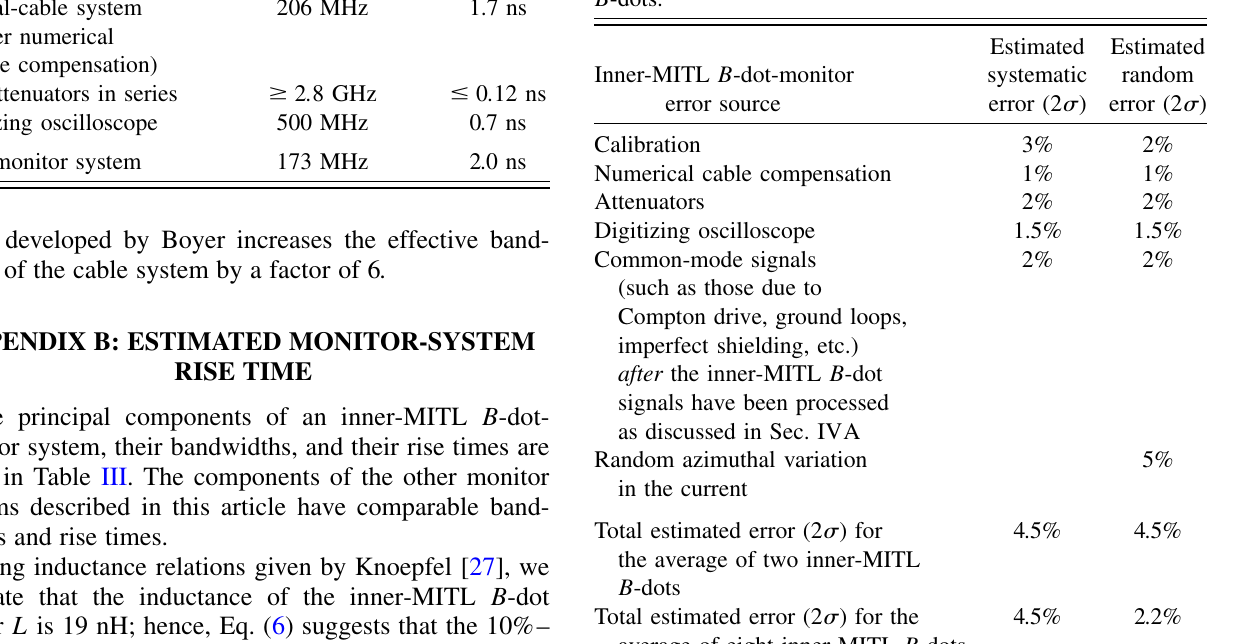
TABLE IV. Estimated systematic and random errors of the inner-MITL B -dot current monitor. The systematic calibration error includes that due to differences between the calibration- system and inner-MITL geometry. The random error due to azimuthal variations is inferred from the measurements pre- sented in Sec. VI. The estimated total random error ( 2 (cid:3) ) in the average value of two inner-MITL B -dots is estimated to be 4.5%. The total random error would decrease to 2.2% for eight B